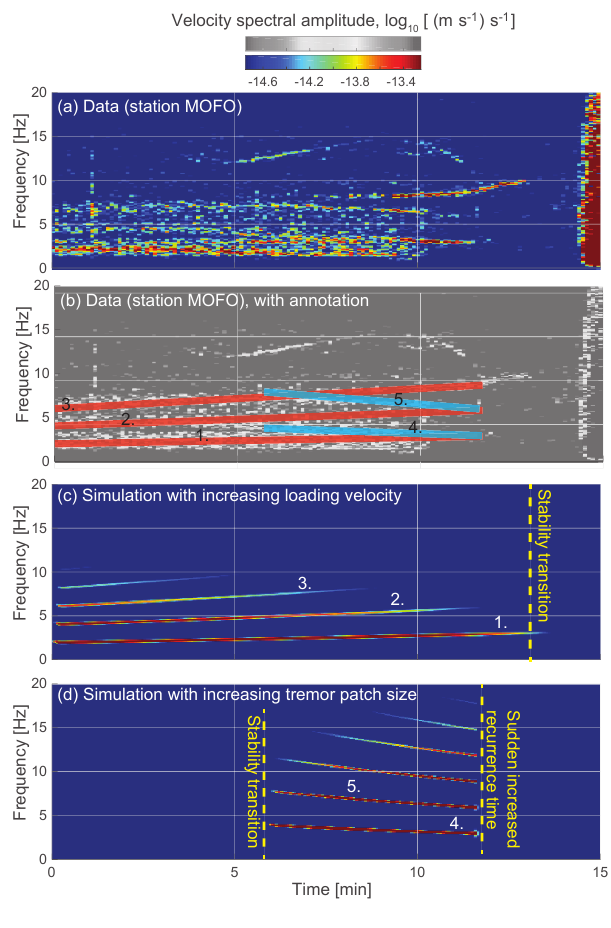
Figure 8. Comparison between observed and simulated seismic tremor showing, (a) a data spectrogram from the MOFO station, and (b) an annotated data spectrogram showing three up-gliding spec- tral bands (labelled 1, 2, 3) and two down-gliding spectral bands (la- belled 4 and 5). The time of large-scale landslide motion is visible in the data at about 14min time. Panels (c) and (d) show numerical simulations with increasing loading velocity and increasing patch size, respectively. Simulation parameters are given in Table 1. The spectrograms in panels (a) , (c) , and (d) are created using the same colour scale and are therefore comparable. The start of the x axis is at 23:10:00UTC.